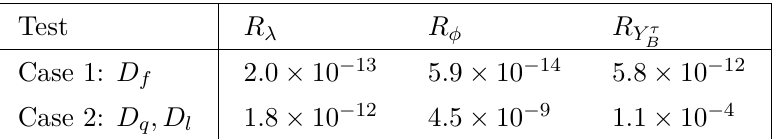
Largest relative differences between the semi- and fully-analytic approaches for the eigenvalues λ , eigenvectors φ , and the baryon asymmetry; approximating a universal diffusion constant for all fermions (case 1), or one diffusion constant for all quarks and one for all leptons (case